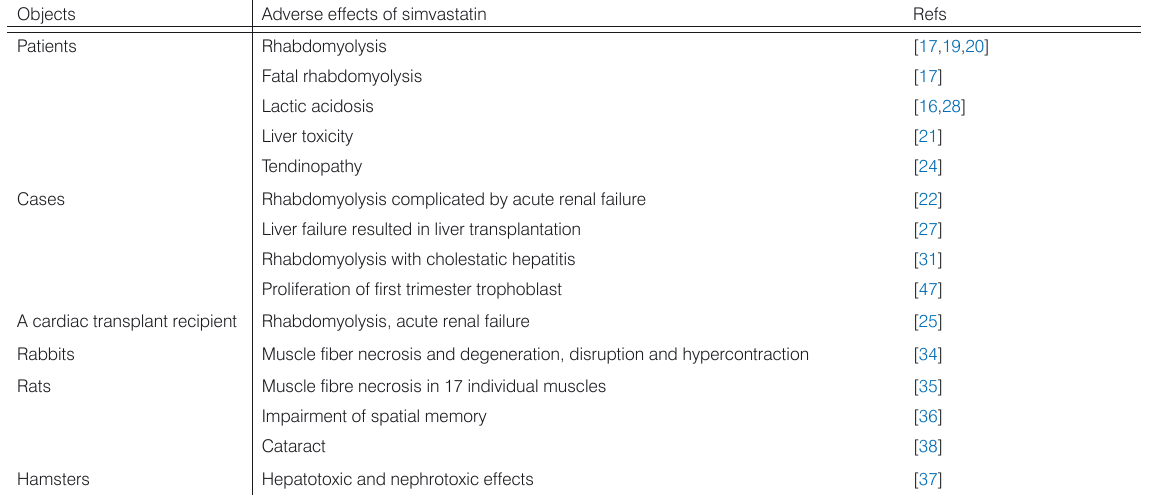
Table 1. Adverse effects of simvastatin in humans and